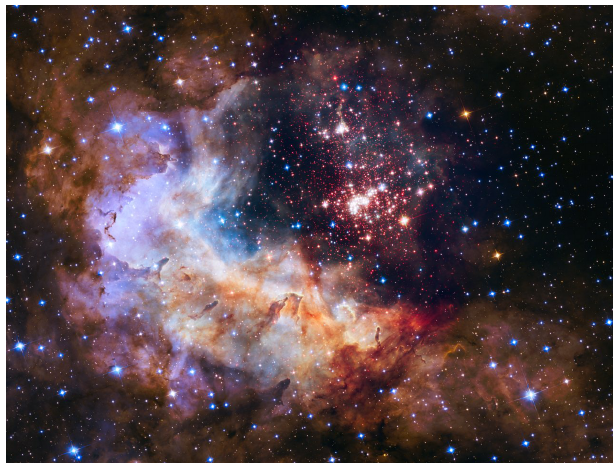
Fig. 1.— Image of the open star cluster Westerlund 2, taken by the Hubble Space Telescope. The image data was downloaded from spacetelescope.org. Image credit: NASA, ESA, the Hubble Heritage Team (STScI/AURA), A. Nota (ESA/STScI), and the Westerlund 2 Science Team